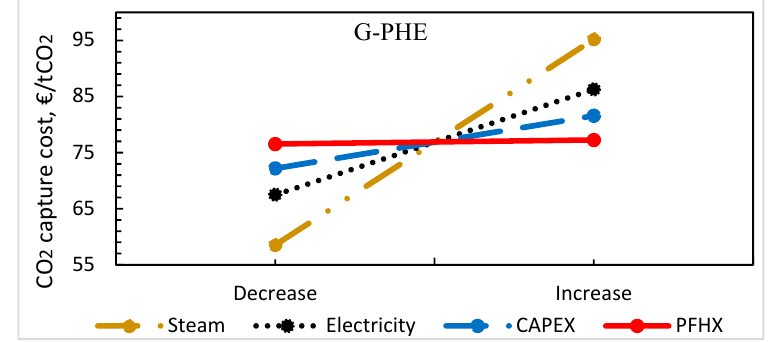
Figure 13. Sensitivity of important economic variables on the capture cost of the W-PHE case.